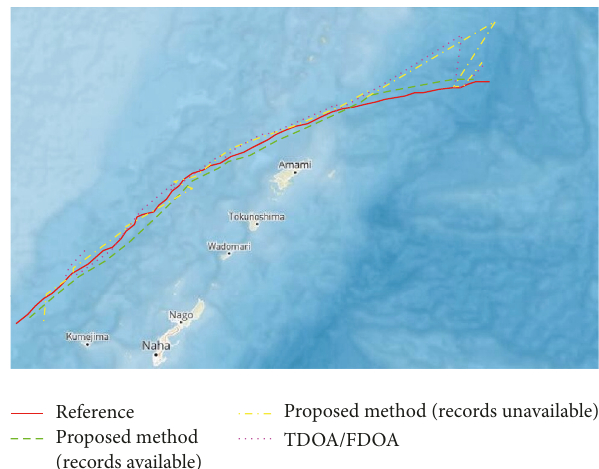
Figure 2: Reference and estimated vessel